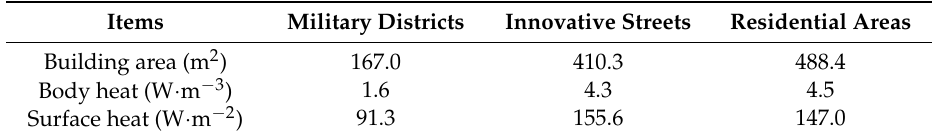
Table 2. The calorific intensity in summer.